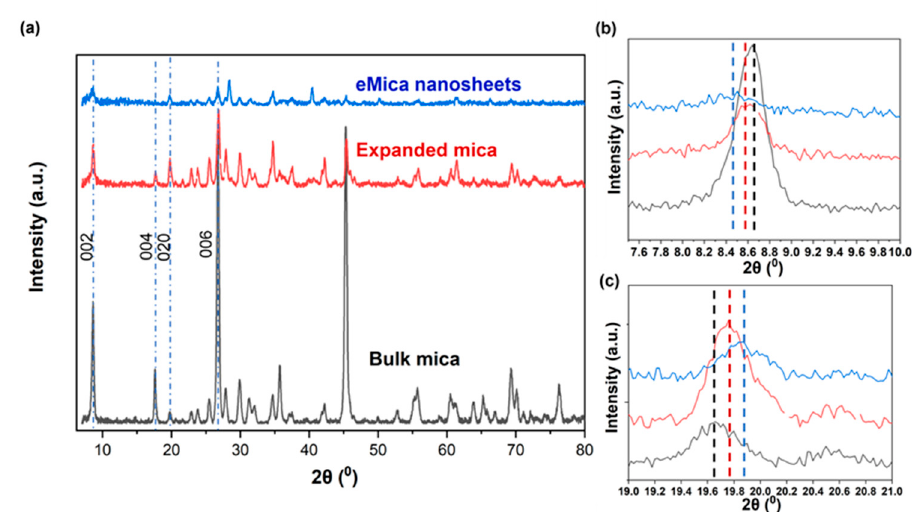
Figure 1. XRD of ( a ) bulk mica, expanded mica and eMica nanosheets, ( b ) enlarged image of peak between 7 and 17, and ( c ) enlarged image of peak between 17 and 26.